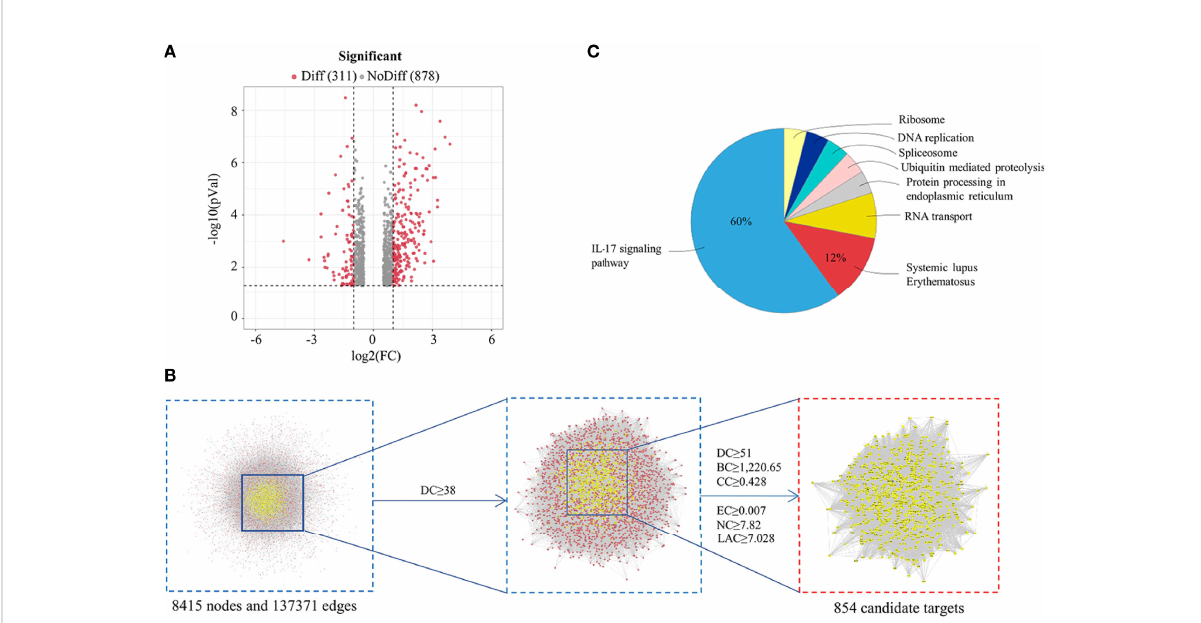
FIGURE 2 Analysis of HDW treatment LN Based on Network Pharmacology. (A) Differential expression volcano map shows the differentially expressed genes in LN samples; grey pixels represent genes where the difference in expression is not signi fi cantly different, red pixels represent signi fi cant ones; the X-axis displays log2 fold change, and the Y-axis indicates the -log10 p-value . (B) Topological analysis of the protein-protein interaction network. (C) KEGG enrichment analysis of HDW targets in treating